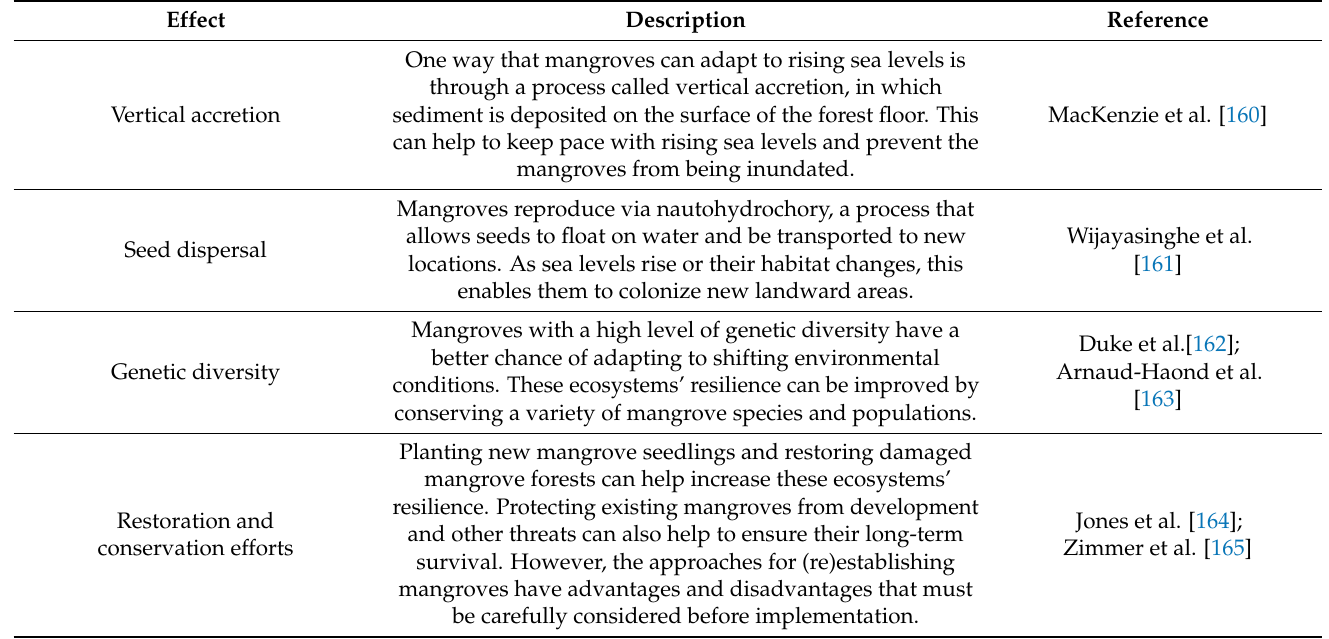
Table 13. Adaptation strategies and resilience of mangrove